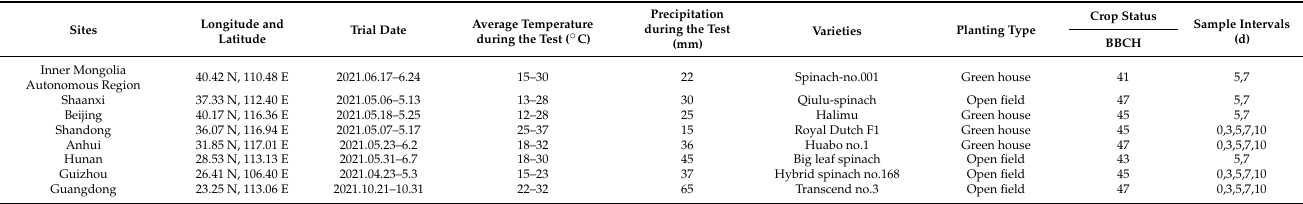
Table 1. Information on field experiments in eight representative areas. Sites Varieties PlantingType